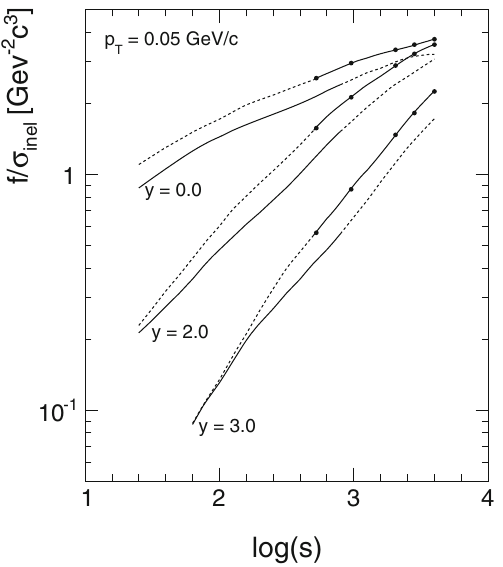
Fig. 7 π − cross sections f /σ inel for the reference sample of HBC and NA49 results compared to the ISR data (points) as a function of cms energy, at p T = 0 . 05 GeV/c. The full lines represent the original, feed- down subtracted reference data and the ISR data without subtraction; the broken lines show the reference data with feed-down added and the ISR data with feed-down subtraction,